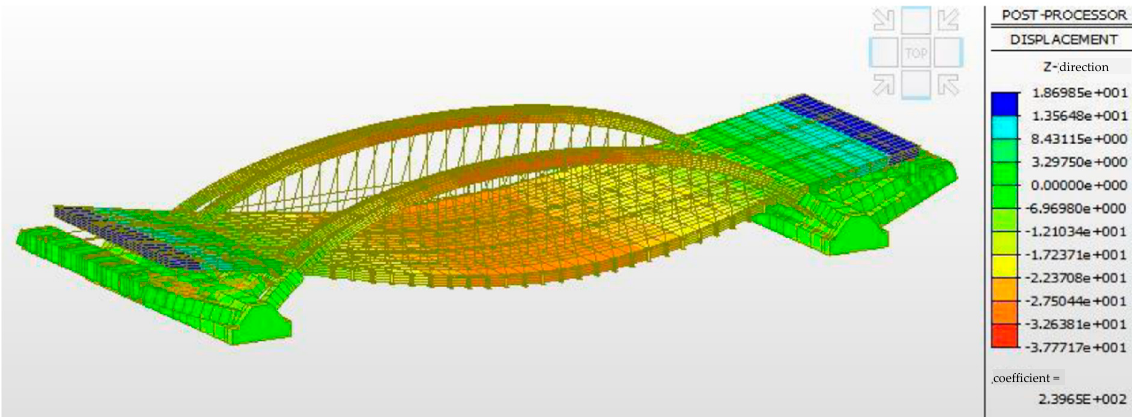
Figure 29. Theoretical deformation of the temperature action of overall cooling at 25 °C (unit: mm).